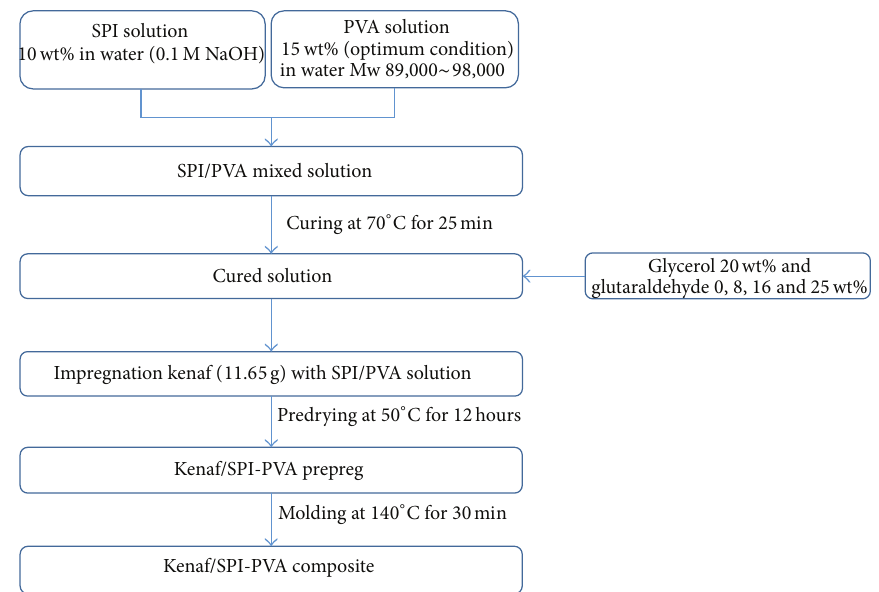
Figure 3: Manufacturing process of the kenaf/SPI-PVA composite.